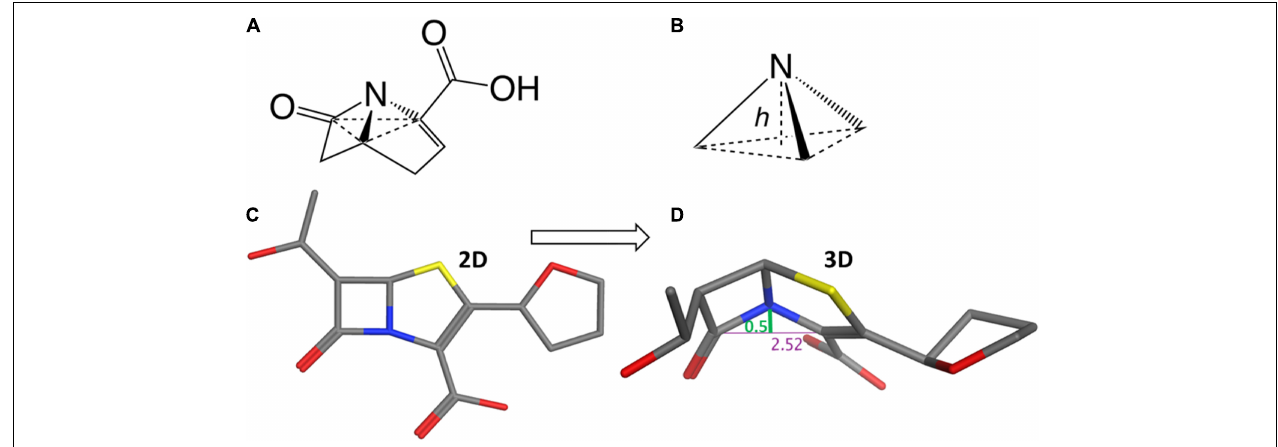
FIGURE 3 | Structural flexibility of β -lactams and the h-Woodward coefficient. (A) General bicyclic β -lactam structure rendered to show pyramidal nitrogen. (B) Depiction of h-Woodward, defined by height of nitrogen to trigonal pyramid ligand base. (C) Faropenem depicted in stick form. (D) Faropenem energy minimized (using MOE with the Amber10:ETH forcefield) and angle of the bent nitrogen bonds showing the h-Woodward of 0.5